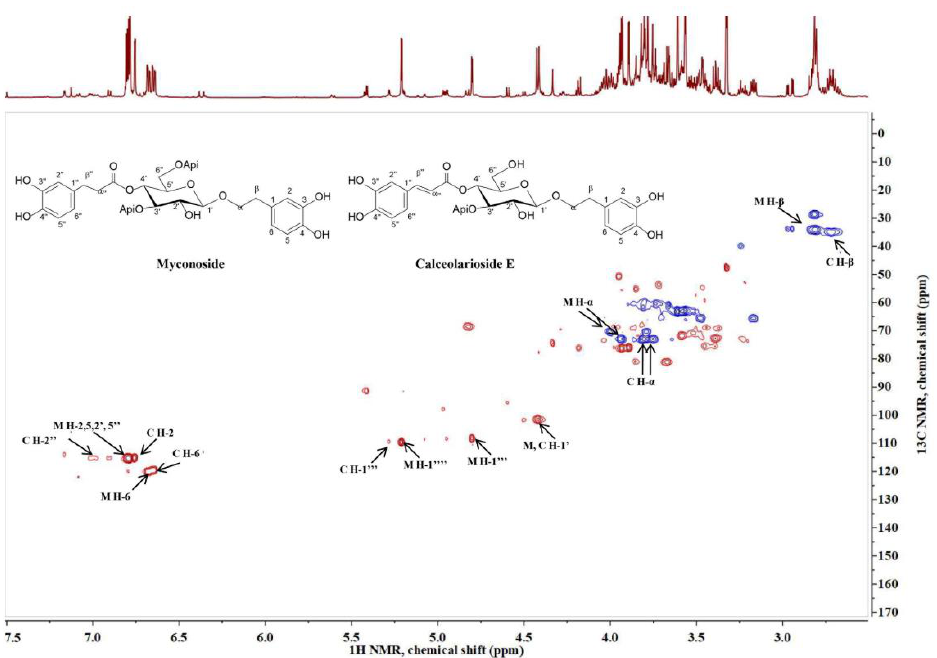
Figure 2. Heteronuclear single quantum coherence spectroscopy (HSQC) spectra of Haberlea rhodopensis extract and the characteristic signals of myconoside (M) and calceolarioside E (C). The NMR signals corresponding to the structures of hispidulin 8- C -(2- O -syringoyl- β -glucopyranoside) and hispidulin 8- C -(6- O -acetyl-2- O -syringoyl- β -glucopyranoside) were in agreement with previously published data [10].